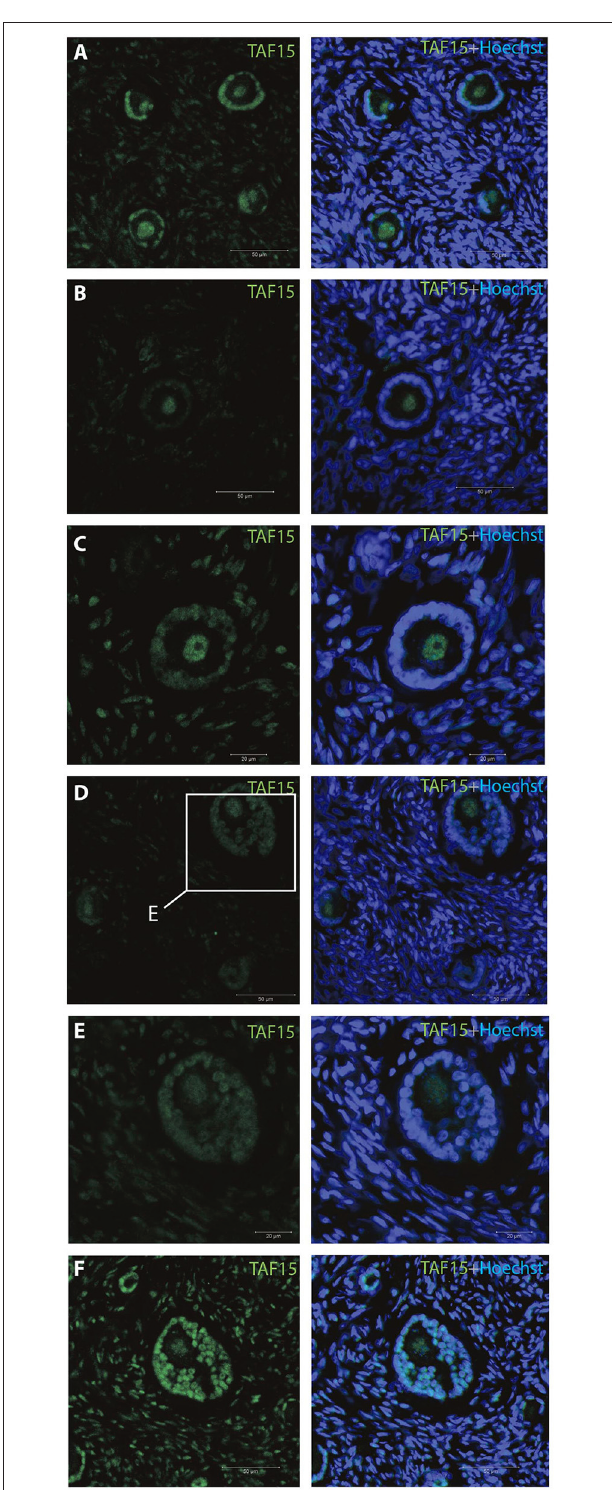
FIGURE 3 | Intra-ovarian distribution of TAF15 in human primordial and primary follicles. This showed detection of the TAF15 protein in both oocyte and granulosa cells of (A) primordial, (B) primary, and (C) secondary, as well as (D–F) small pre-antral/early antral follicles. Hoechst staining identifies the nucleus of cells. Scale bars; 30 µ m.